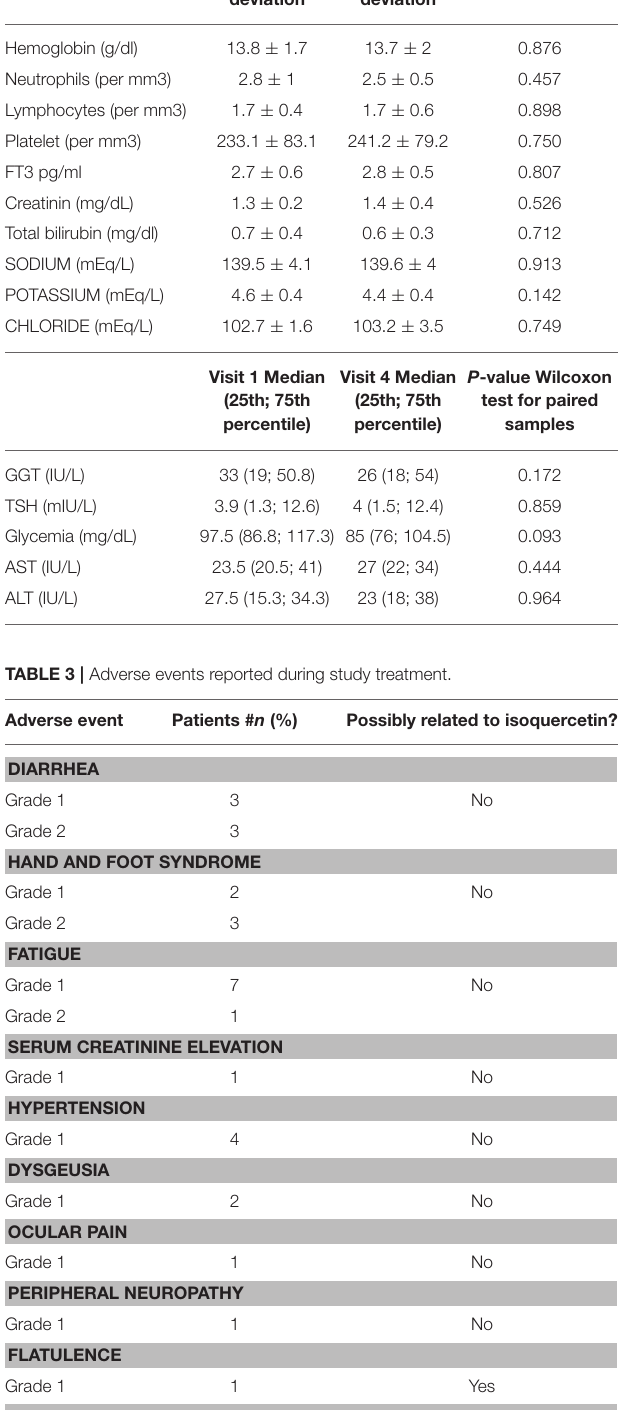
Hemoglobin (g/dl)